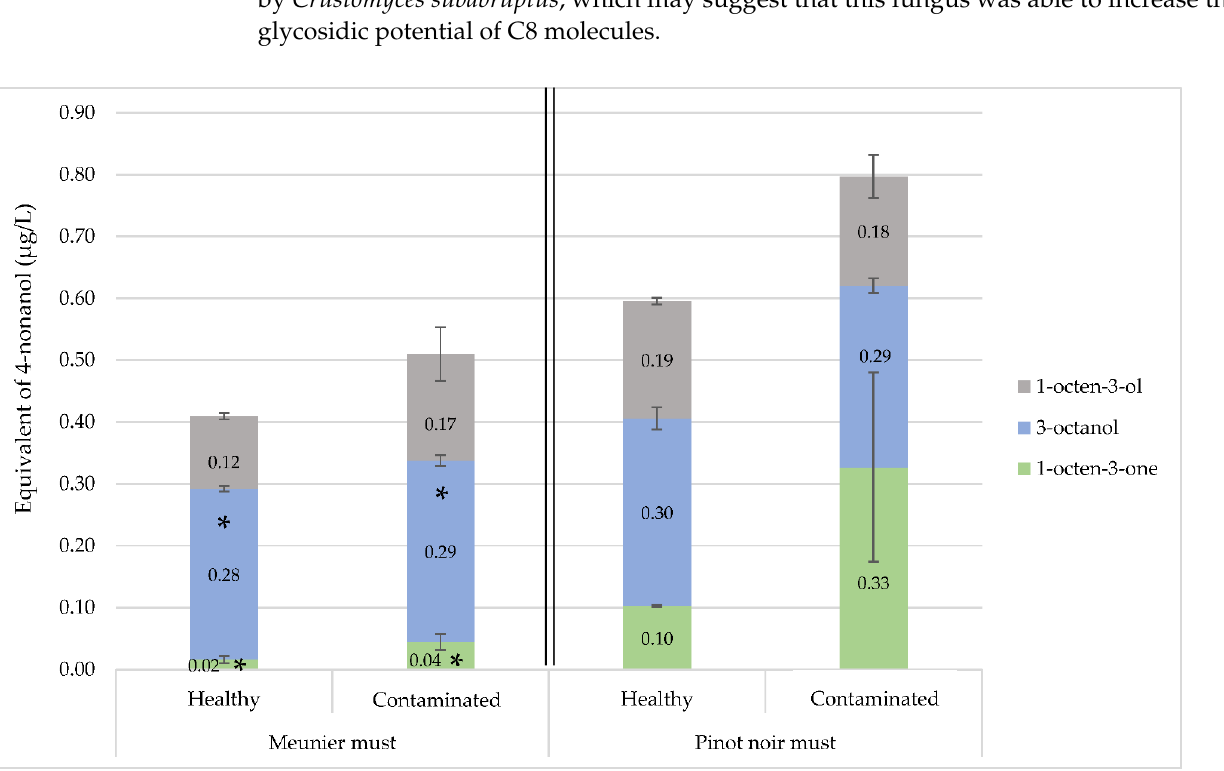
Figure 3 . Concentrations of 1-octen-3-one, 3-octanol and 1-octen-3-ol in healthy and